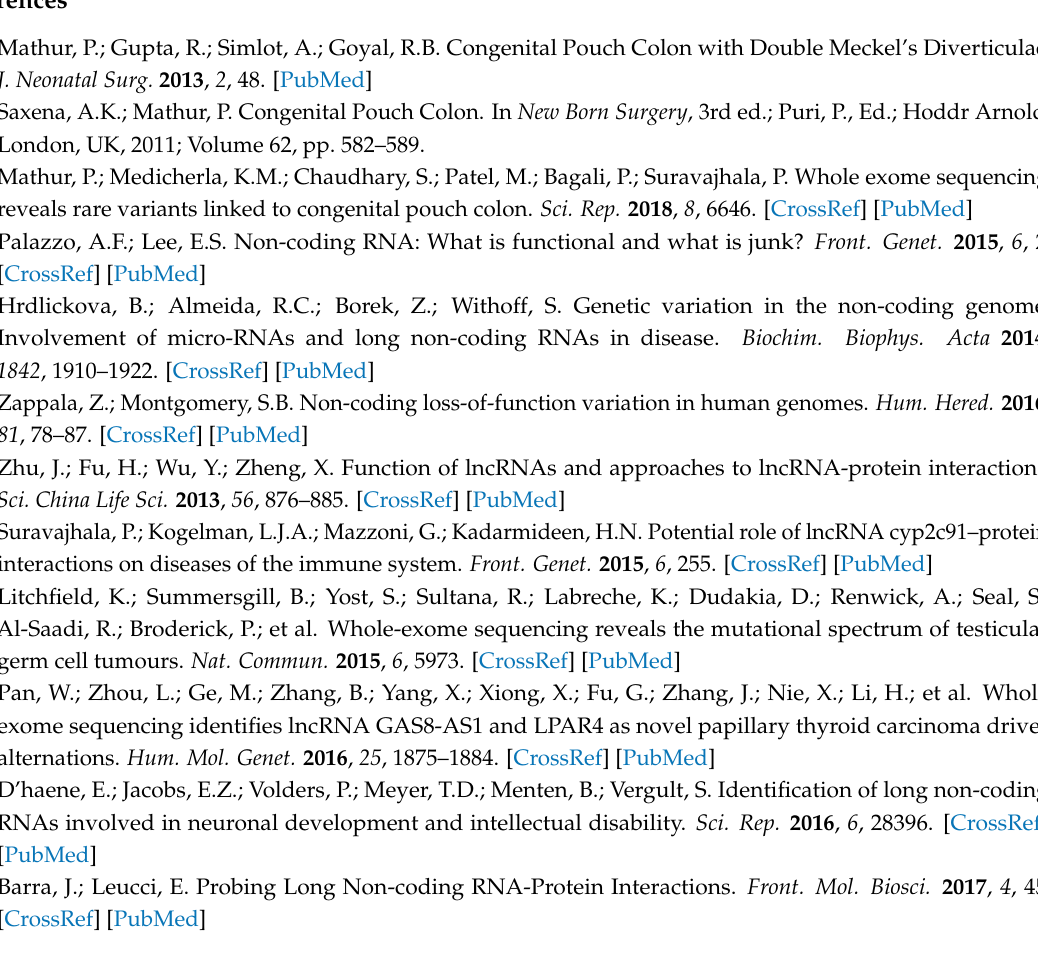
Table S1: The lnc -EPB41-1-1 associated with regulatory elements, viz. transcription factor binding sites, promoters, CTCF motifs up/downstream. Supplementary Information: Thermal shift images of protein KIF13A with lnc -EPB41-1-1 using TychoTM NT.6. Author Contributions: S.G., N.G. and P.T. contributed equally to the project and performed the experiments.